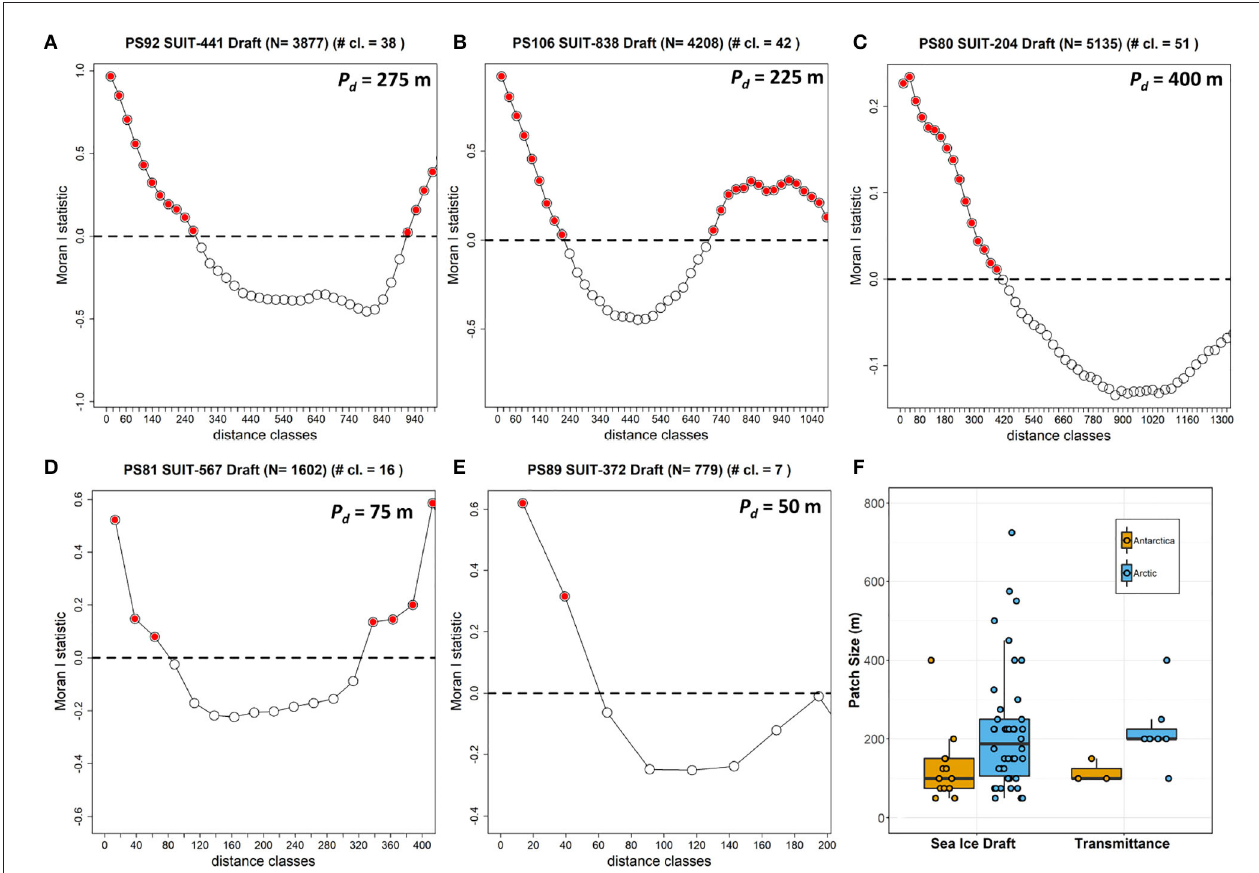
FIGURE 8 | Correlograms showing Moran’s I vs. distance classes for selected SUIT surveys as examples in the Arctic (top row): (A) PS80 station 204_1; (B) PS92 station 44_1; (C) PS106 station 83_8; and in Antarctica: (D) PS81 station 567_2; (E) PS89 station 37_2. Red filled circles represent significant values at p < 0.05. (F) Boxplot summarizing all sea ice draft patch sizes determined from all SUIT surveys grouped by polar